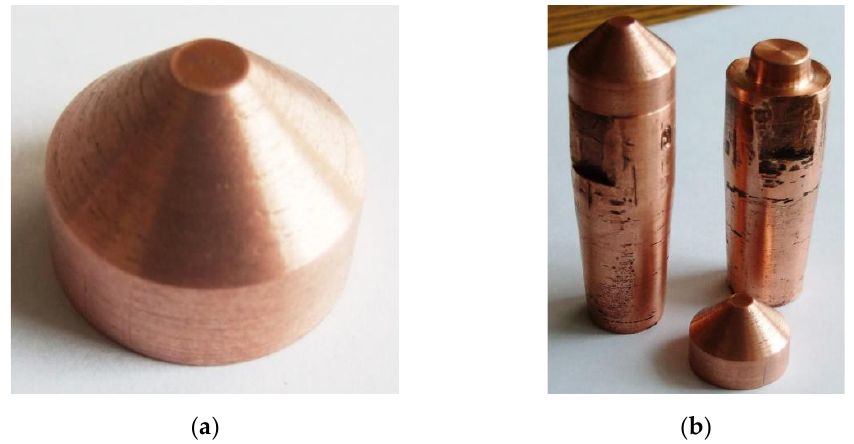
Figure 12. Socket electrode tips made of Cu5T copper composite and electrode pins on which the tips